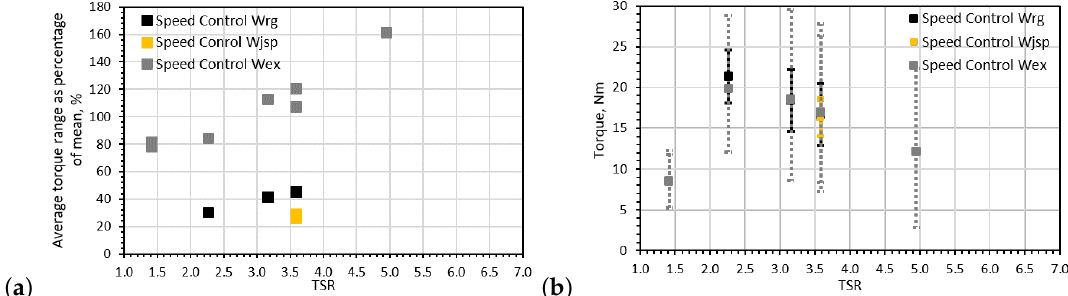
Figure 10. Average rotor torque fluctuation per wave period only for speed control cases: ( a ) the torque fluctuation range as a percentage of the mean rotor torque for each case is shown and ( b ) the average maximum and minimum rotor torque per wave period are indicated by the extremes of the error